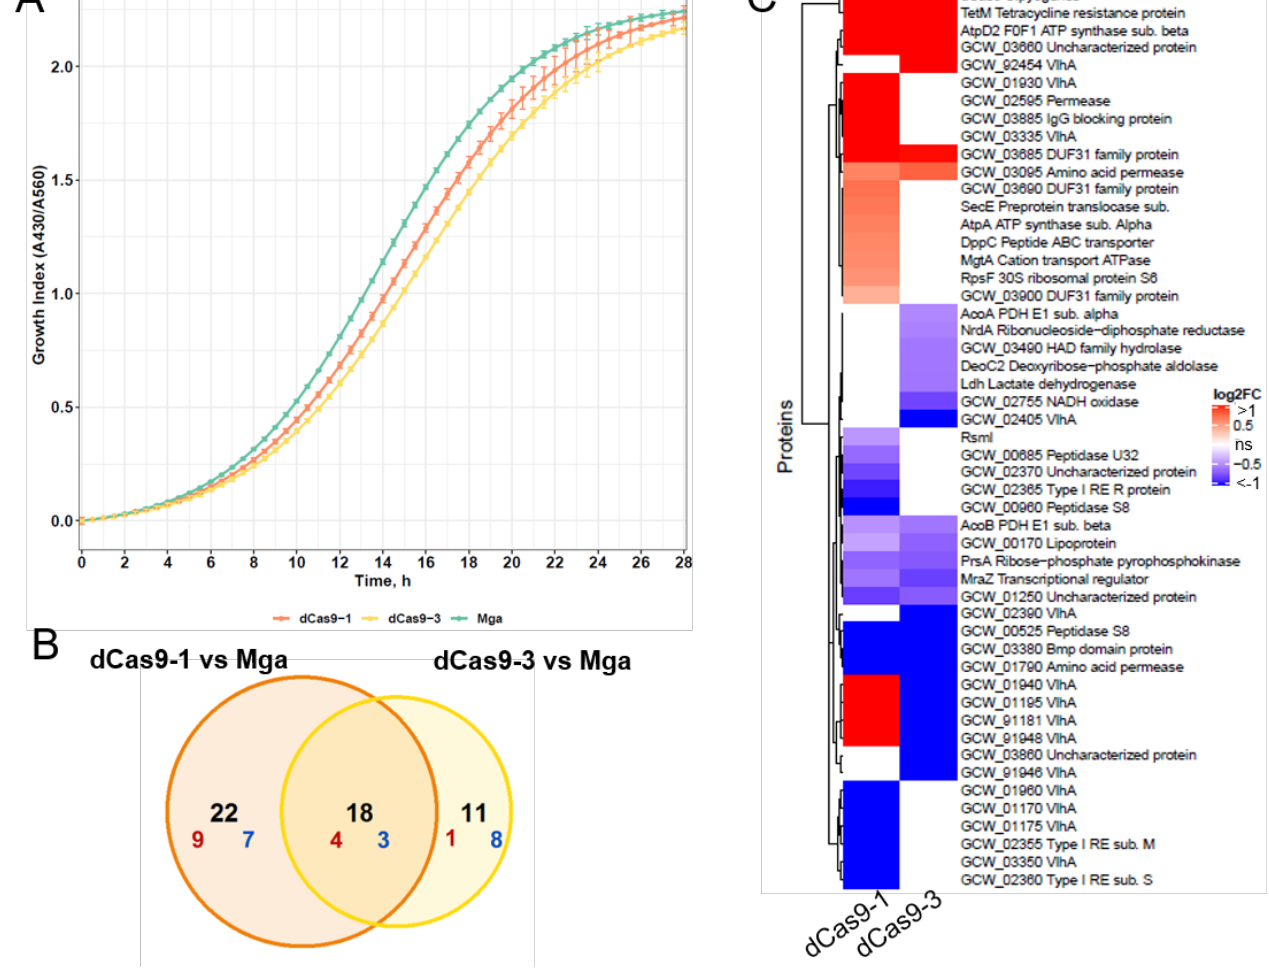
Figure 3. Effect of dCas9 expression on growth rate and protein levels in M. gallisepticum ( A ) Growth curves for wild-type M. gallisepticum (Mga) and two transformants expressed cas9 (dCas9-1 and dCas9-3) were evaluated through the color change of the medium supplied with phenol red. ( B ) Venn diagram of the number of differentially expressed proteins from dCas9-1 and dCas9-3 transformants of M. gallisepticum when compared to wild type bacteria. The overlap shows the number of proteins that demonstrated co-directional change in two dCas9-expressed clones. The number of proteins with log fold change more than one are highlighted in red, with a log fold change less than one highlighted in blue. ( C ) The changes of protein levels while dCas9-expression is illustrated in the heatmap. White boxes are the proteins with non-significant changes ( p adj. > 0.05).